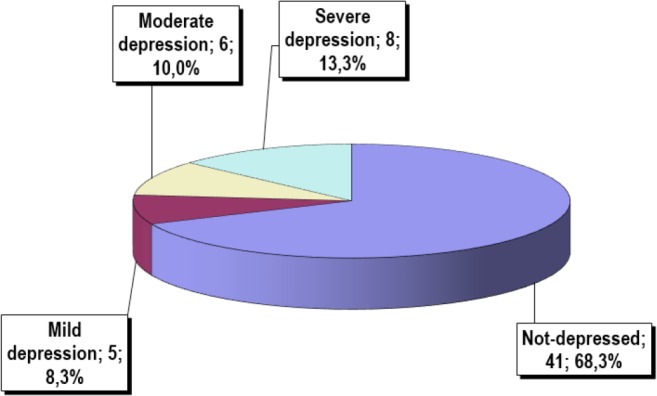
Pie chart showing the relative frequency of selected severity categories of diagnosed depression in the study sample.